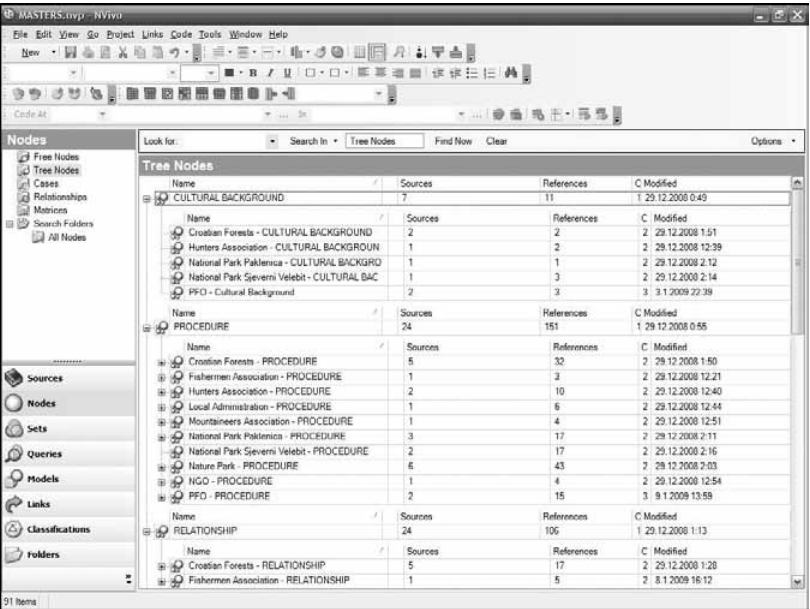
FIguRe 2 Tree nodes in